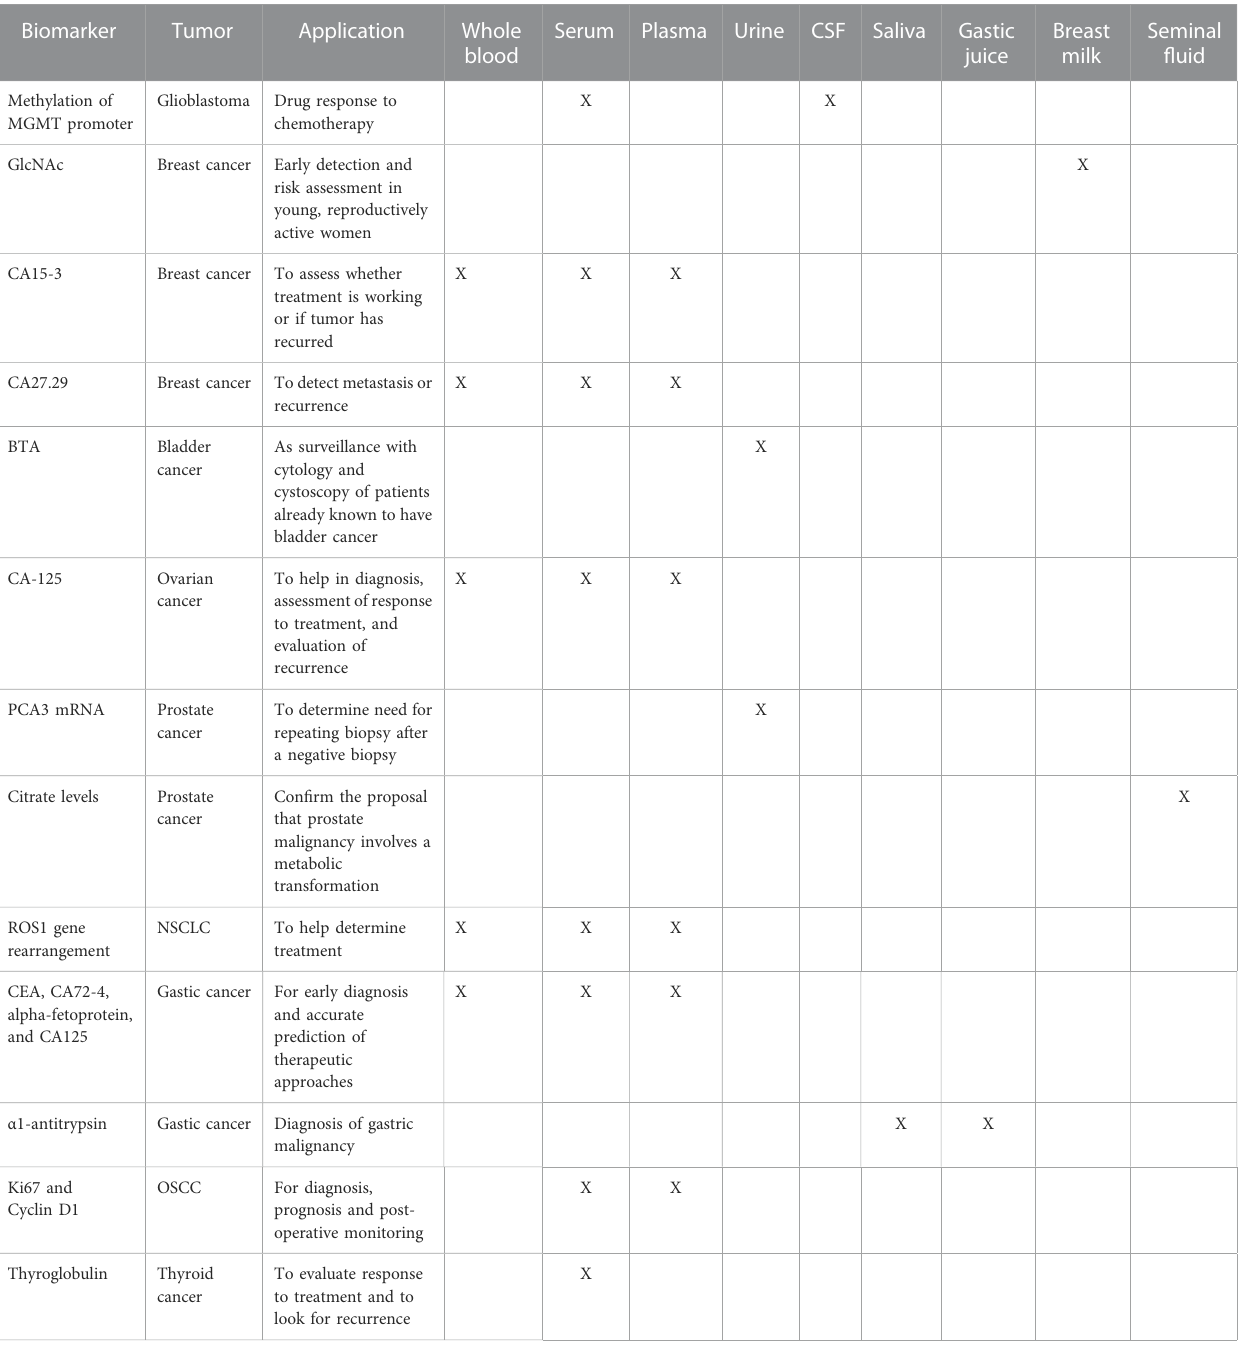
TABLE 1 Commonly studied tumor biomarkers from different biological fl